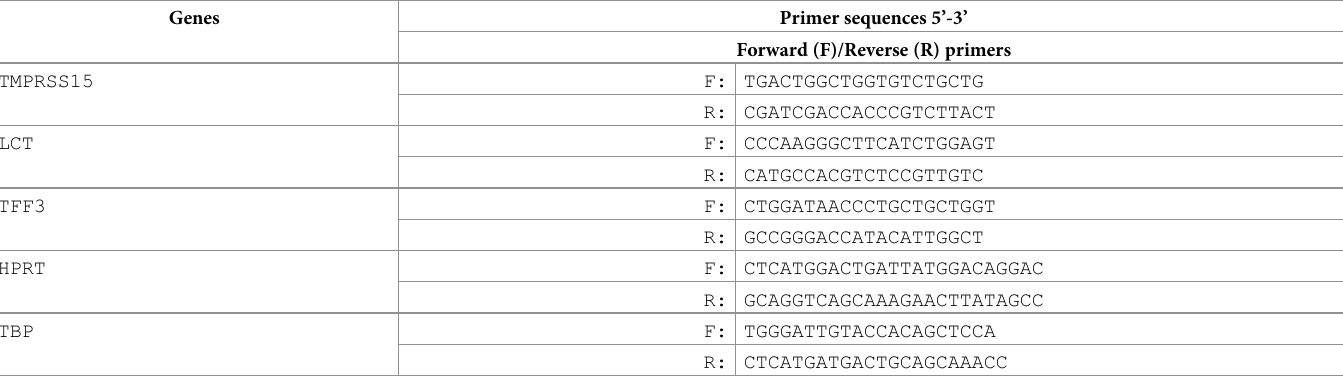
Table 1. Primer sequences for the real-time